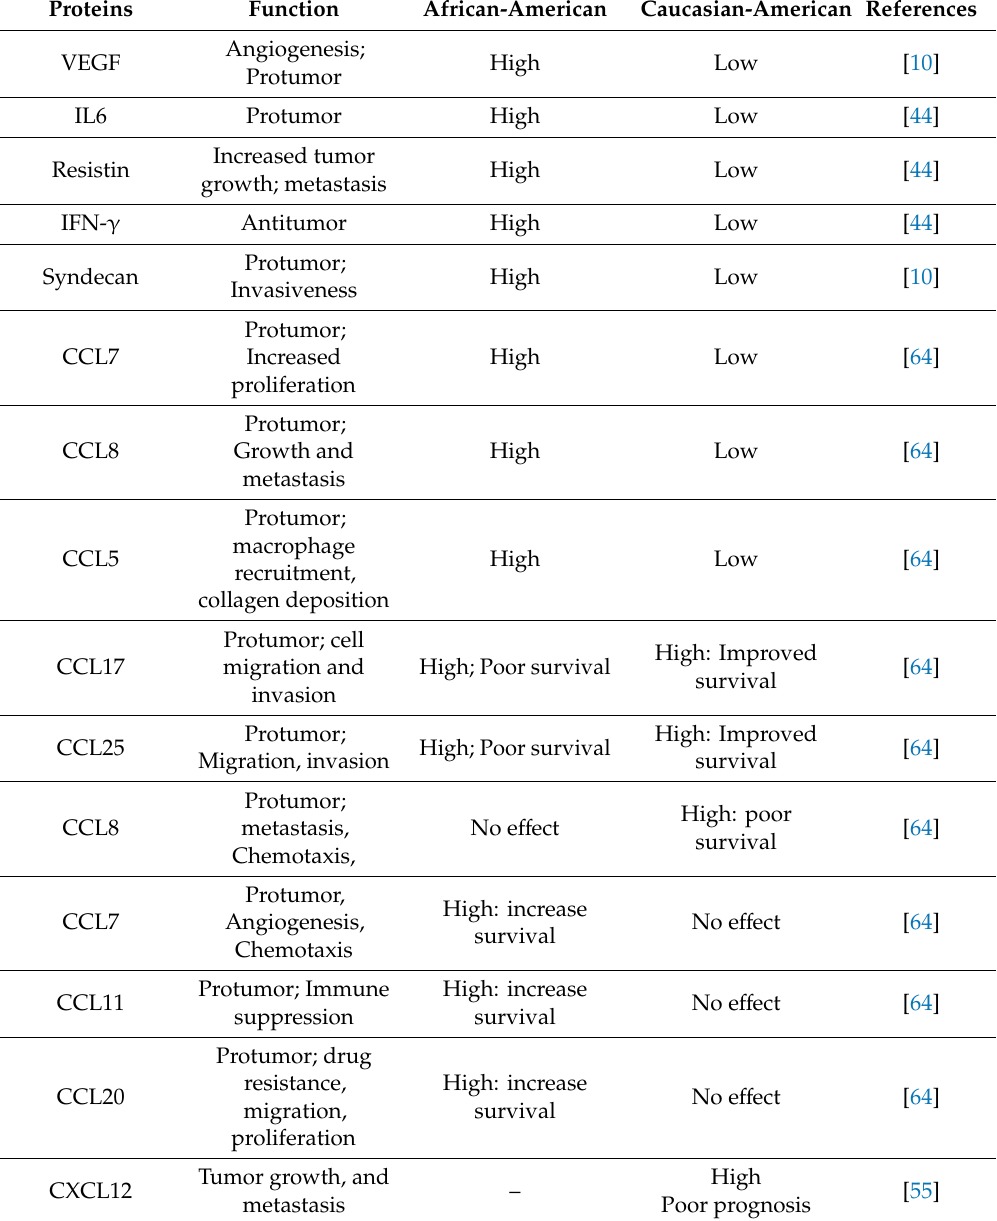
Table 2. Disparate recruitment of proteins and cytokines in breast